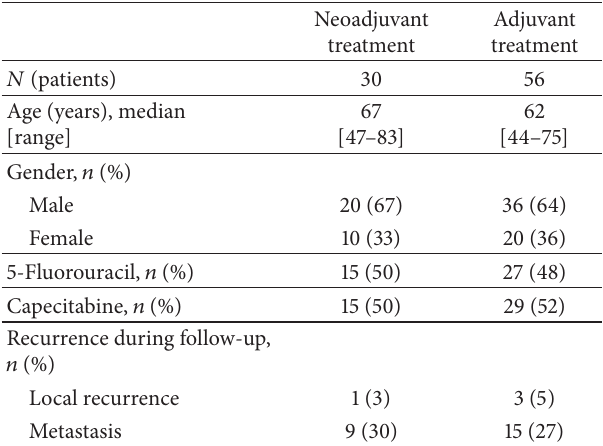
Table 2: Patients’